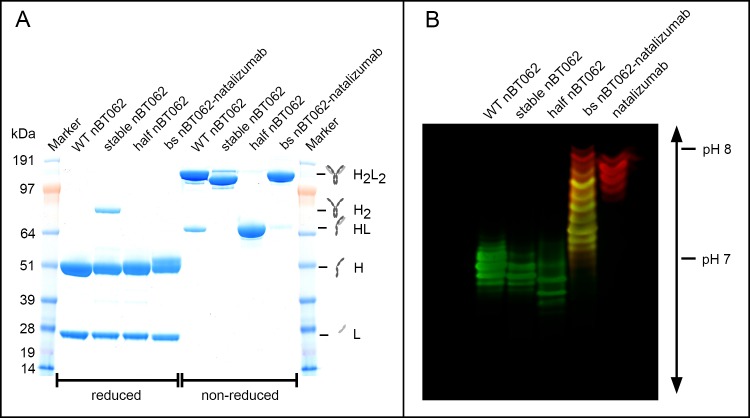
Analytical characterization of nBT062 model variants.(A) Reducing and non-reducing SDS-PAGE analysis of indicated nBT062 variants. L = light chain, H = heavy chain, HL = half antibody, H2 = heavy chain dimer, H2L2 = intact antibody. Molecular weight and antibody explanations are representative for reducing and non-reducing conditions. (B) Indicated nBT062 model variants were separated by isoelectric focusing and blotted onto a PVDF membrane. Selective BT062 and natalizumab specificities were detected by anti-idiotypic antibodies visualized in green and red respectively. The bispecific nBT062-natalizumab fraction is showing two natalizumab exclusive bands.